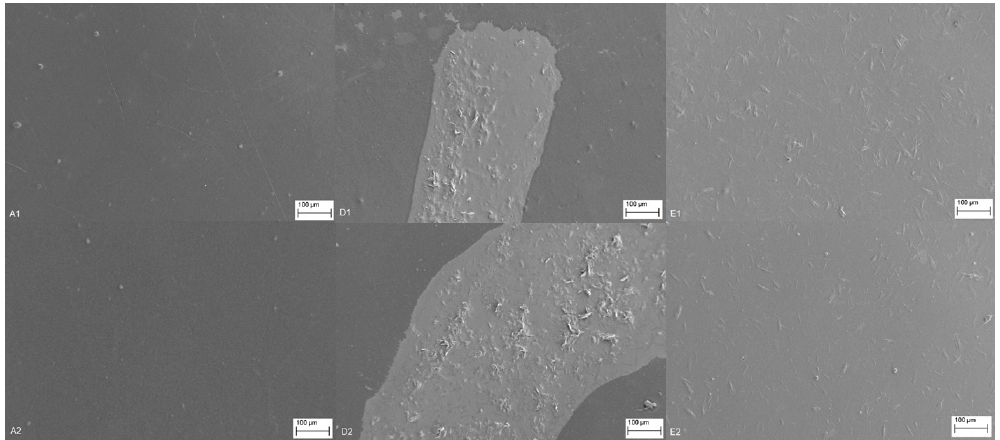
Figure 6. SEM micrographs of functionalized surface of PE and PP with resveratrol-loaded chitosan- sodium tripolyphosphate (TPP) nano dispersion.